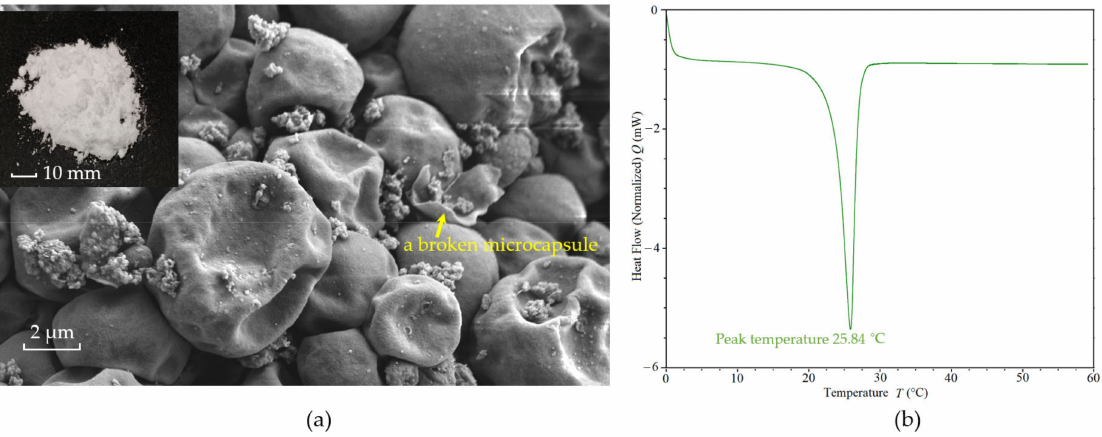
Figure 1. MPCM: ( a ) MPCM sample and SEM image, the microcapsules shrinking due to vacuum operation before SEM tests and ( b ) DSC curve of the